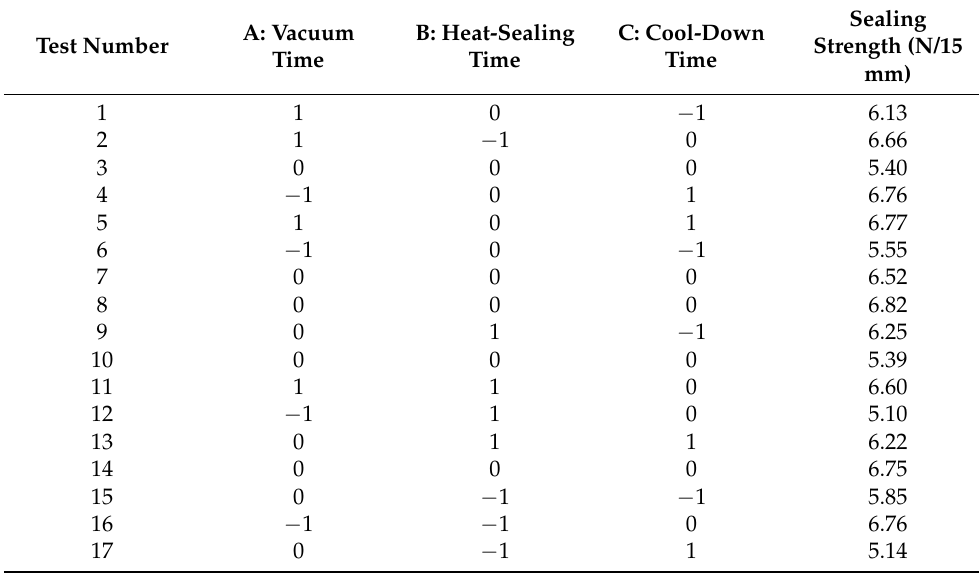
Table 3. Response surface experimental design and results of the influence of vacuum time, heat- sealing time, and cooling time on heat-sealing strength. A: Vacuum Test Number